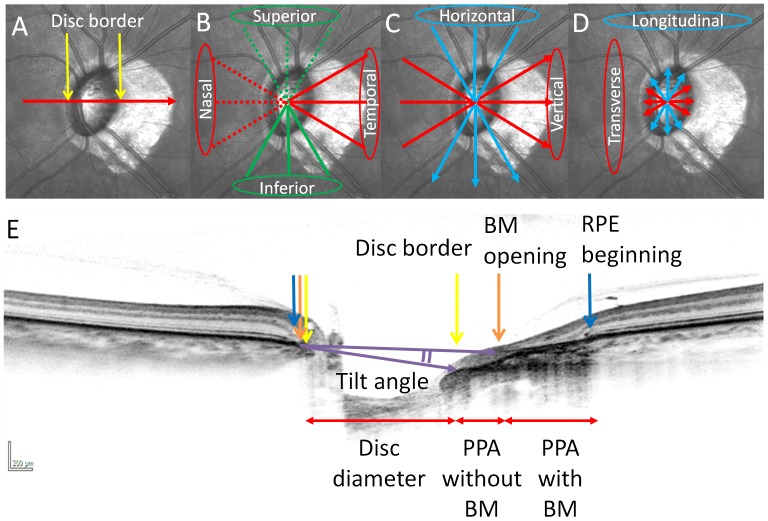
Measurement of PPA lengths, tilt angles and disc diameters with spectral-domain optical coherence tomography (SD-OCT) in the left eye.(A–D) Infrared (IR) images of the optic disc. (E) SD-OCT B-scan image oriented according to the red arrow in (A). Disc border (yellow arrows), RPE (blue arrows) and Bruch's membrane (BM) (orange arrows) were shown in (A, E). PPA lengths were categorized into superior, inferior, temporal, and nasal lenghs (B). Tilt angle was determined by the angle between the two lines drawn between the BM termination point and disc border (two purple arrows). Tilt angle was categorized into horizontal and vertical tilt angles (C). Disc diameter was defined as longitudinal and transverse diameters (D).